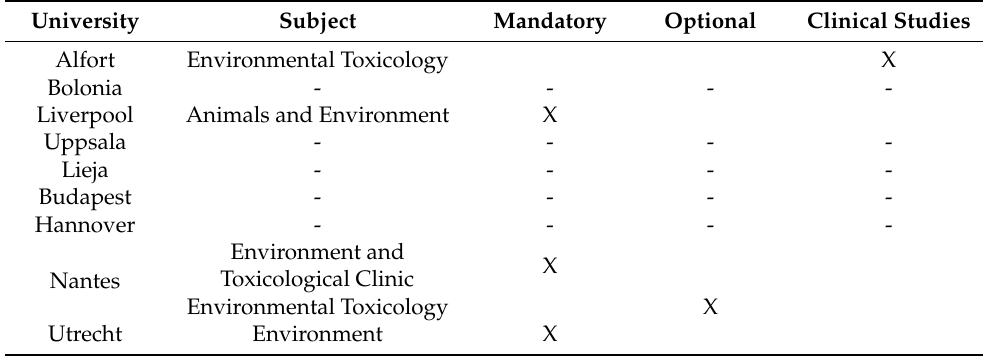
Table 2. Subjects related to environmental issues of nine Veterinary Faculties in